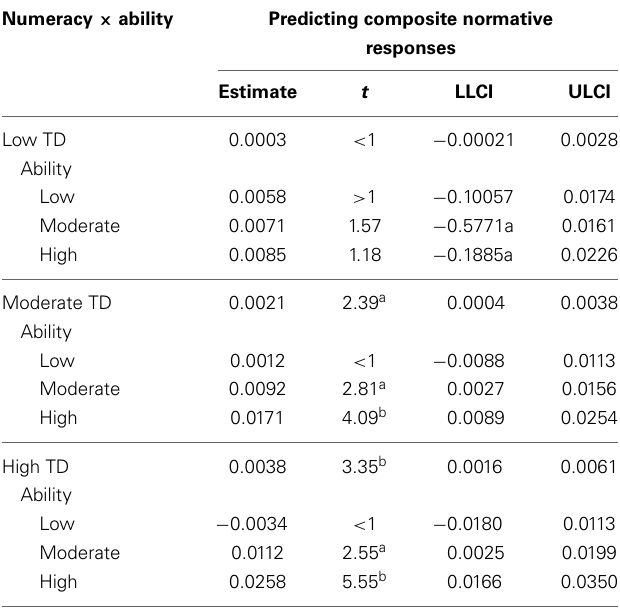
Table 5 | Moderated mediation results: effects of numeracy on normative responding by TD level and ability level (within TD